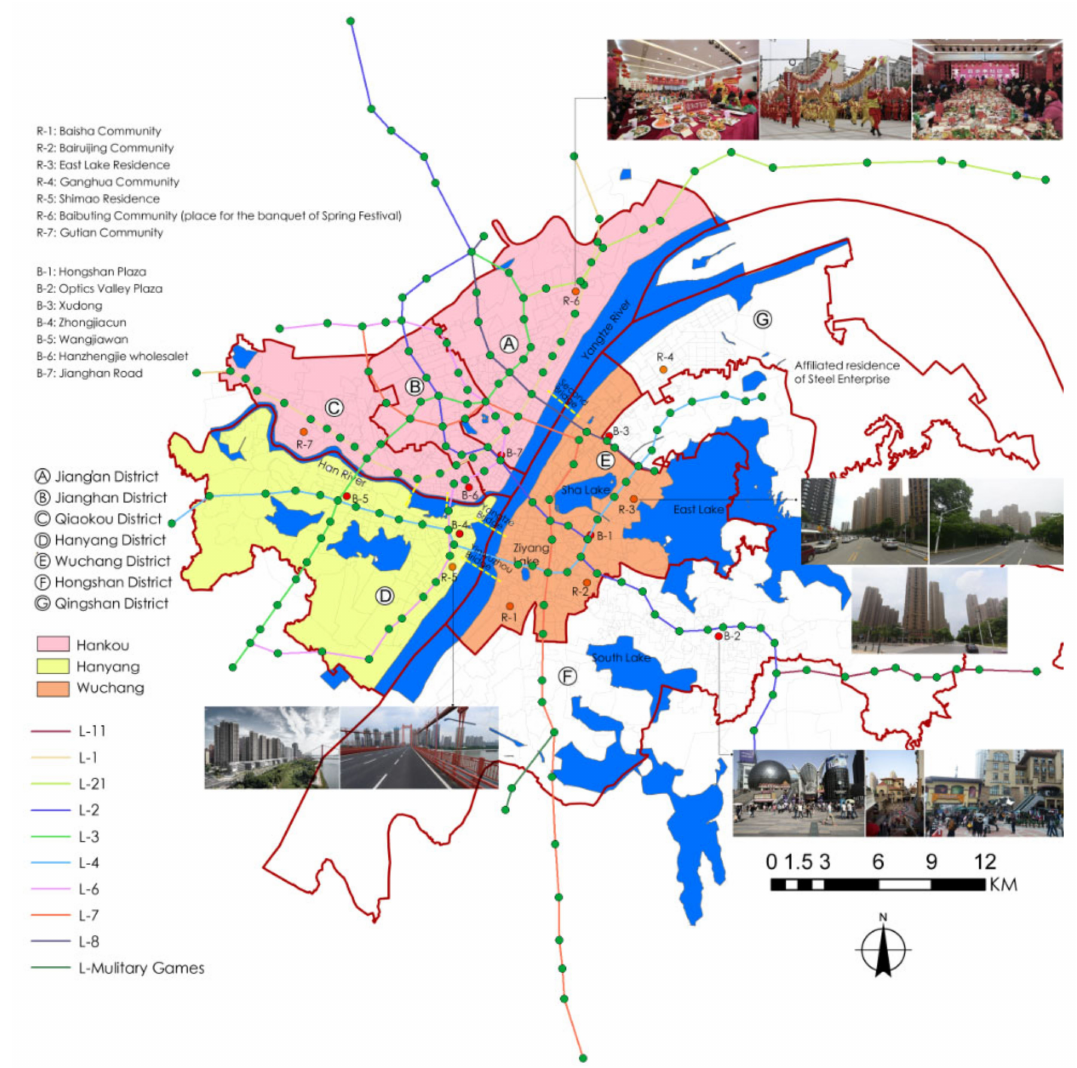
Figure 1. The basic geographic information of the study area and characteristics of urban